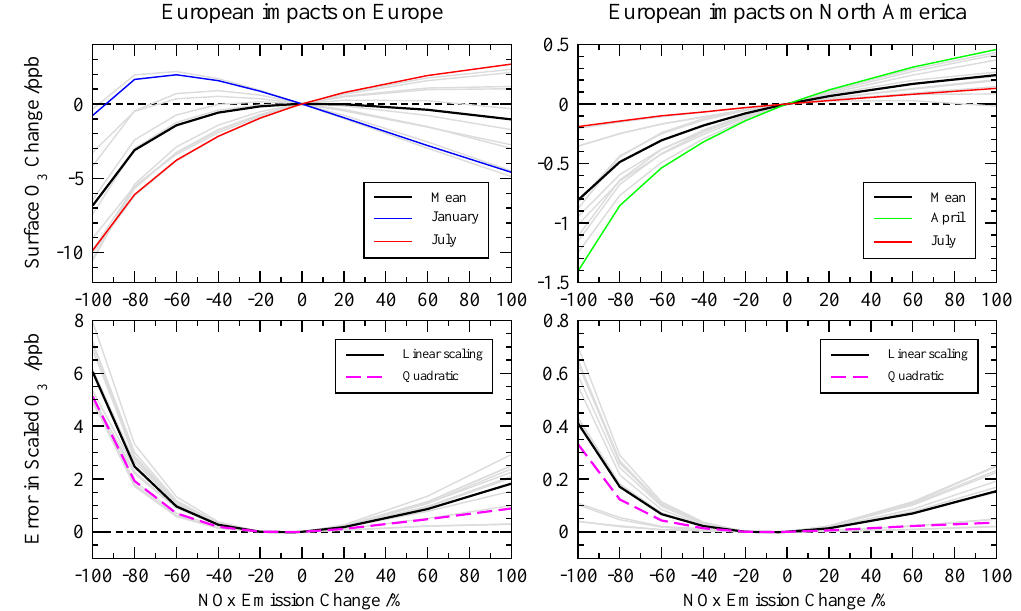
Fig. 3. Sensitivity of monthly O 3 changes in the FRSGC/UCI CTM to the magnitude of European NO x emissions relative to current conditions over the source region (left) and a downwind receptor region (N. America, right). Annual mean O 3 responses are shown in black and individual months in grey; months with the largest and smallest responses are highlighted. The lower panels show the error associated with linearly scaling a 20% emission perturbation over the source and receptor regions (annual error in black, monthly errors in grey, scale factor “f”) and using a quadratic scaling (annual error in magenta, scale factor